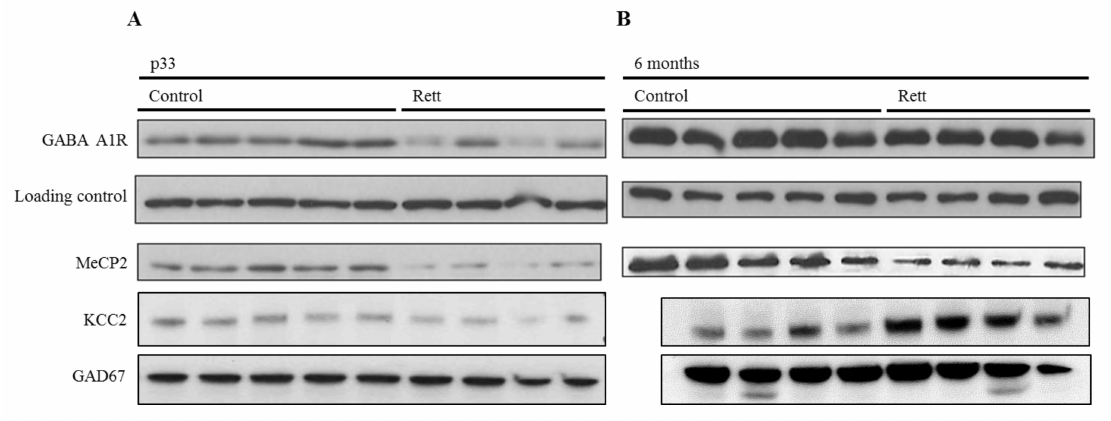
Figure 3. Developmental expression analysis of GABAergic proteins in the MeCP2 − /+ mouse brain cortex. Representative Western blot analysis of the GABA A -A1R, KCC2, GAD67, and MeCP2 E1 expression in the adult cortex of female Rett and control mice. ( A ) Expression in p33-pre-symptomatic mice (control vs. pre-symptomatic Rett mice). Vinculin was used as a loading control. ( A ) Expression in six-months old mice (control vs. symptomatic Rett mice). Both Western blots ( A , B ) are cropped stripes of two di ff erent membranes each, and incubated with each antibody separately (target protein and loading control respectively). Each lane is a di ff erent animal. Representative blots